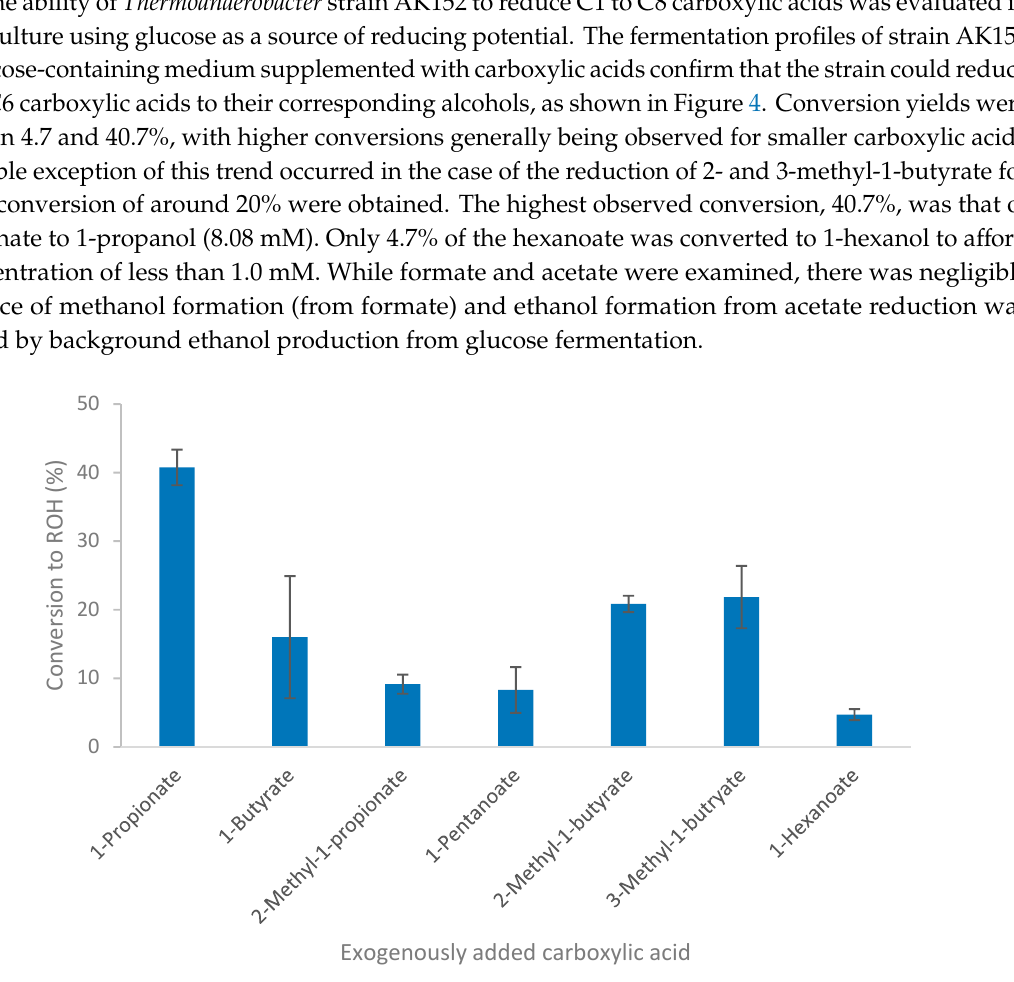
Figure 4. Conversion of short-chain fatty acids by Thermoanaerobacter strain AK152 using glucose (20 mM) as a source of reducing potential. Values represent average ± standard deviation ( n = 3).